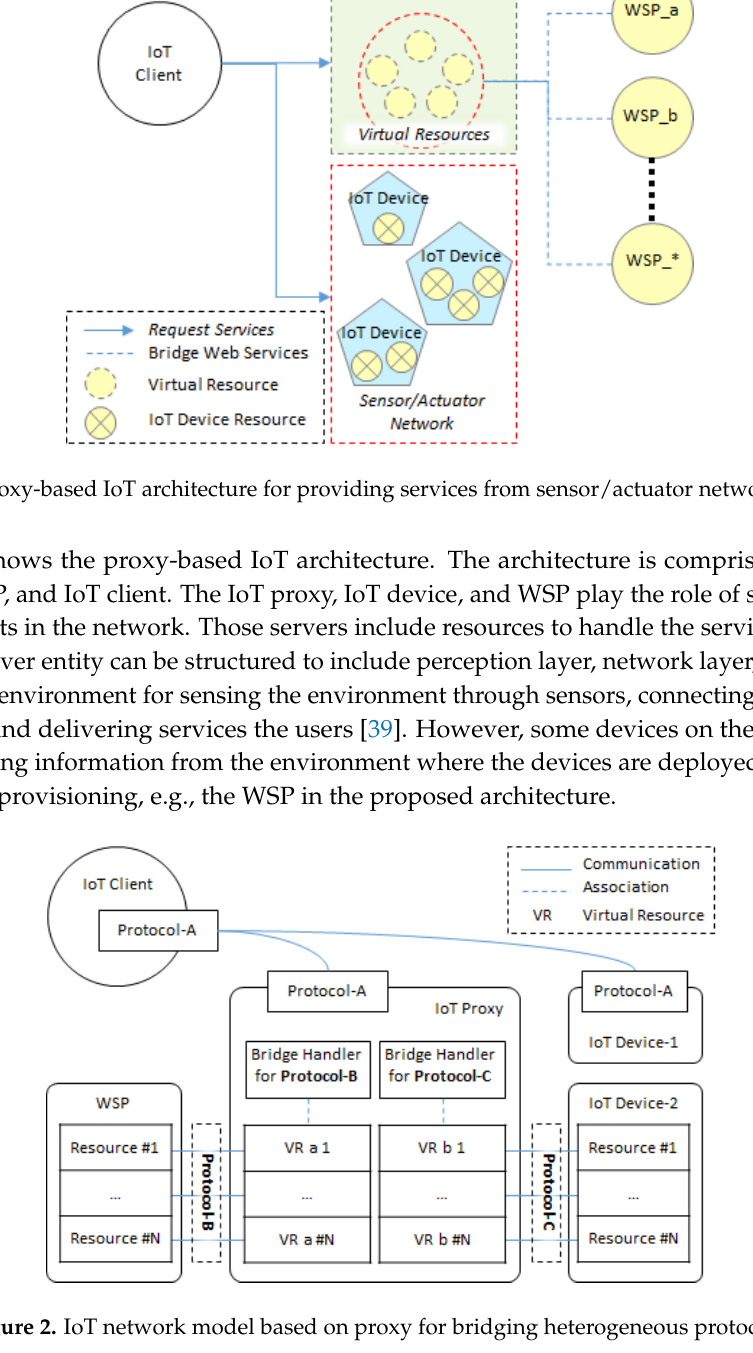
Figure 2. IoT network model based on proxy for bridging heterogeneous protocols.